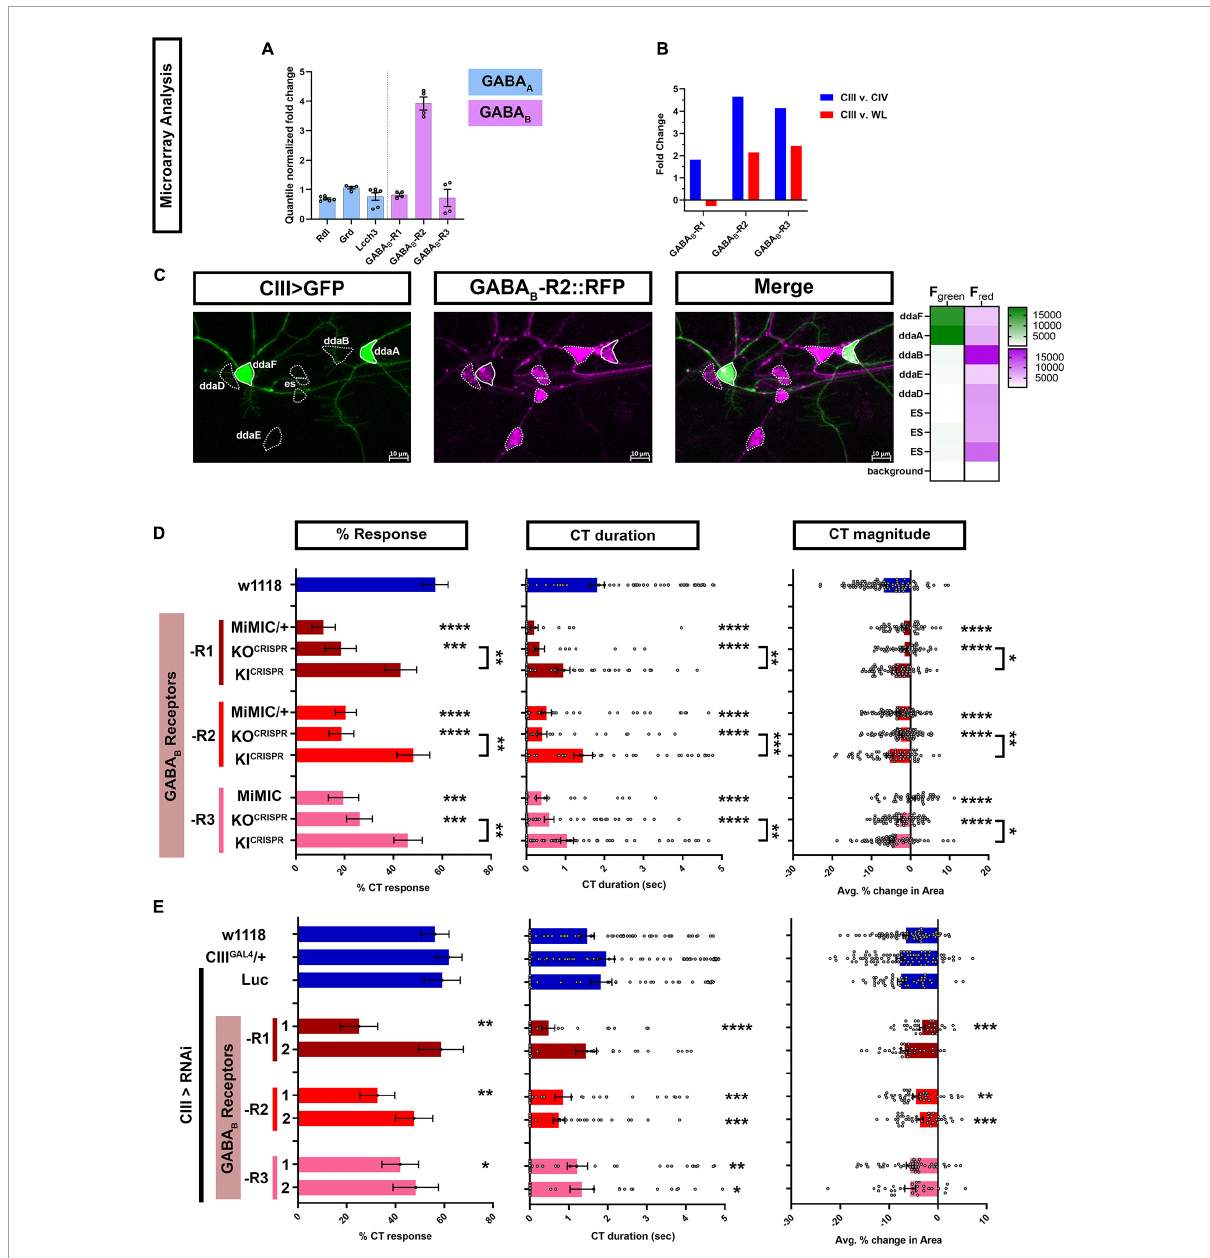
FIGURE1 Metabotropic GABA B are expressed in CIII md neurons and are required for cold-evoked CT behavior. (A,B) md neuron transcriptomic analysis. (A) Quantile normalized expression levels of ionotropic ( GABA A ) and metabotropic ( GABA B ) receptors in CIII md neurons. All receptors are expressed above background levels and GABA B -R2 has very high expression in CIII md neurons. (B) Comparisons of transcriptomes between CIII md neurons and CIV md neurons or whole larvae (WL). We focused on metabotropic GABA receptors, which show, in general, greater expression in CIII md neurons compared to CIV md neurons or whole larvae (WL). (C) Visualization of GABA B -R2 expression in Drosophila larval PNS. CIII md neurons were visualized using membrane anchored GFP expression to mark overall morphology and GABA B -R2 expression was visualized using an RFP tagged GABA B -R2. GABA B -R2 RFP expression is detectable in CIII (ddaF, ddaA), CII (ddaB), CI (ddaD, ddaE), and ES neurons. Genotype: GABA B -R2::RFP, nompC GAL 4 > GFP . (D,E) Cold plate assay assessing cold-evoked behaviors of third instar Drosophila larvae. We report %CT (left), CT duration in seconds (middle), CT magnitude (right). (D) Whole animal mutant analysis of GABA B receptor’s role in cold-evoked behaviors. For each GABA B (-R1, -R2, -R3) receptor, we tested one MiMIC and one CRISPR knockout (KO) line (truncated after first exon and inserted RFP). Additionally, we tested CRISPR GAL4 knock-in (KI) line, which replaces the RFP of KO CRISPR with the remaining exons restoring receptor function. N Average = 65. (E) Class III specific knockdown of GABA B (-R1, -R2, -R3) receptors. Control conditions include: w1118 , 19–12 GAL 4 /+ , and 19–12 > Luc RNAi . There is no statistical difference between the controls. Knockdown of GABA B ( -R1, -R2, -R3 ) receptors was tested with two independent RNAi lines and comparisons made to 19–12 GAL 4 /+ control. N Average = 46. Significant differences indicated via asterisks, where * p < 0.05, ** p < 0.01, *** p < 0.001, and **** p <